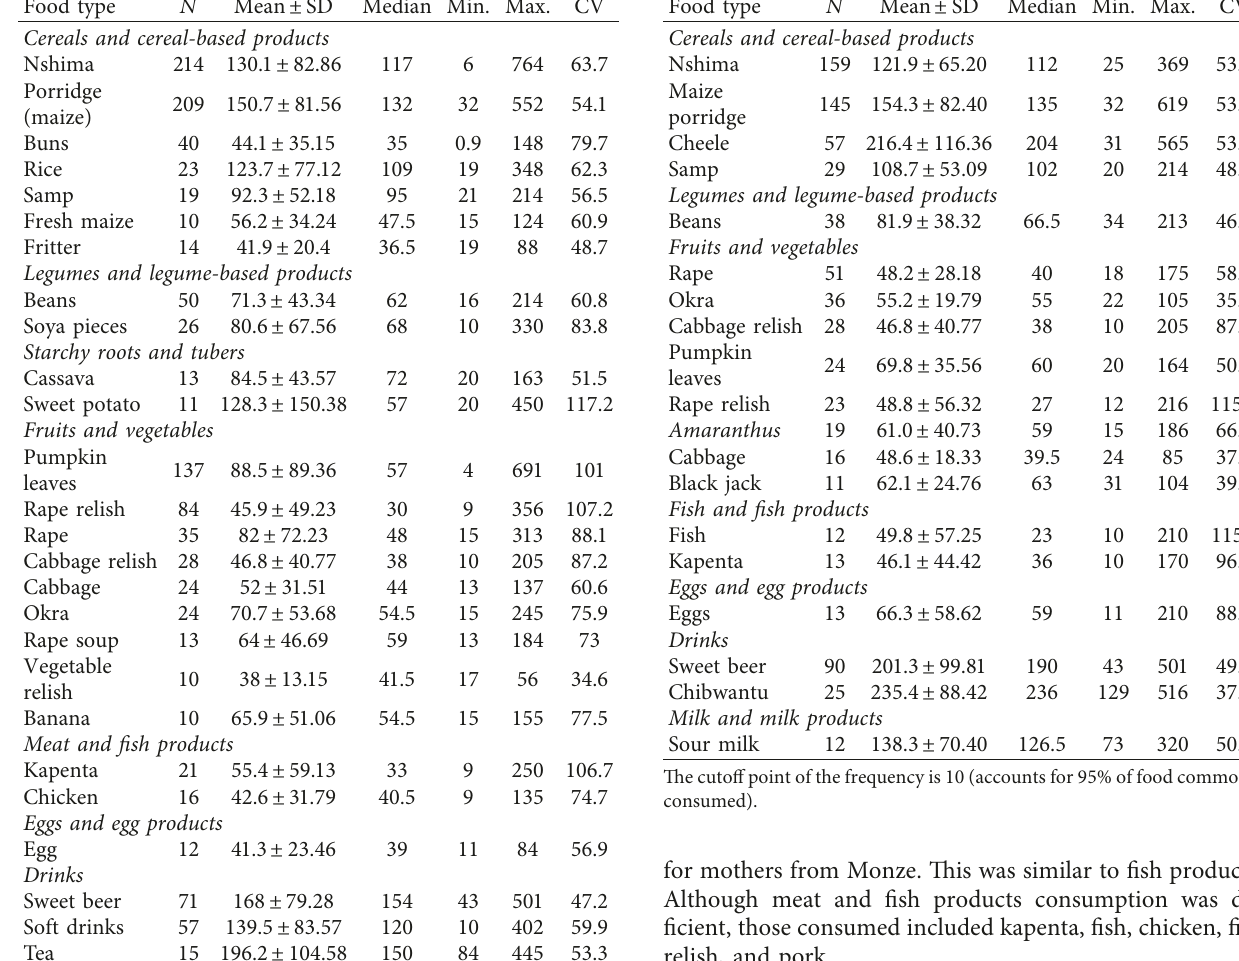
Table 3: Food frequency and weight (grams) of foods consumed by children in Chipata.